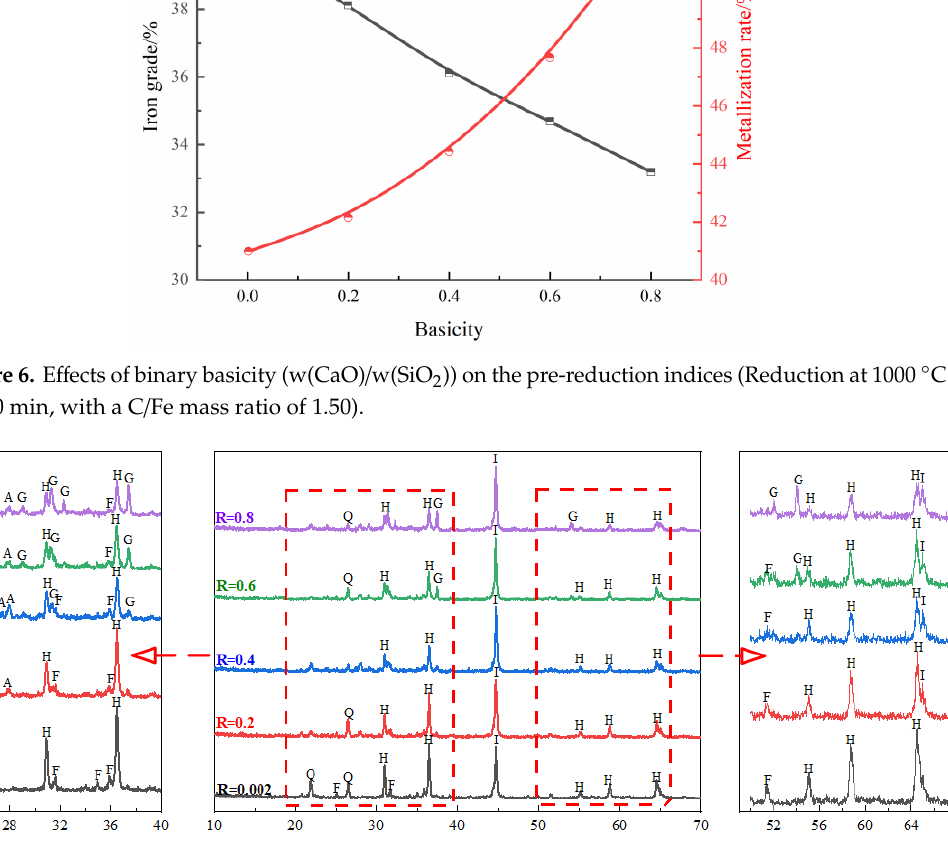
Figure 7. XRD pattern of the pre-reduced pellets at di ff erent binary basicity (w(CaO) / w(SiO 2 )) (A: Albite (Na,Ca)Al(Si,Al) 3 O 8 ; Q: Quartz SiO 2 ; G: Gehlenite Ca 2 Al 2 SiO 7 ;H: Hercynite FeAl 2 O 4 ; F: Fayalite Fe 2 SiO 4 ; I: element Iron;). Table 6. The content of main minerals in the Figure 7 (wt. %).